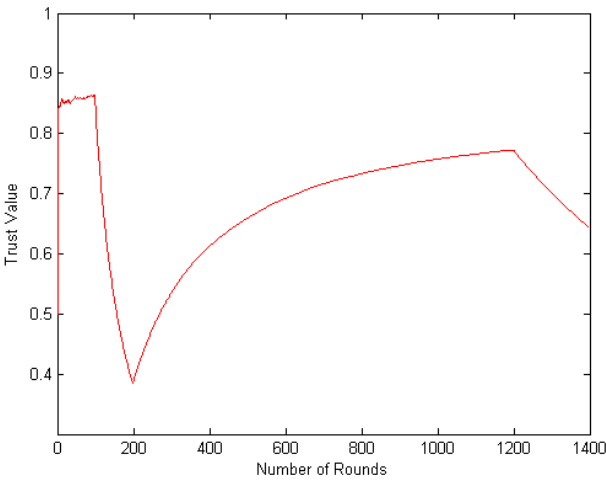
Figure 4. Trust value changes for interaction between a normal node and a malicious node.